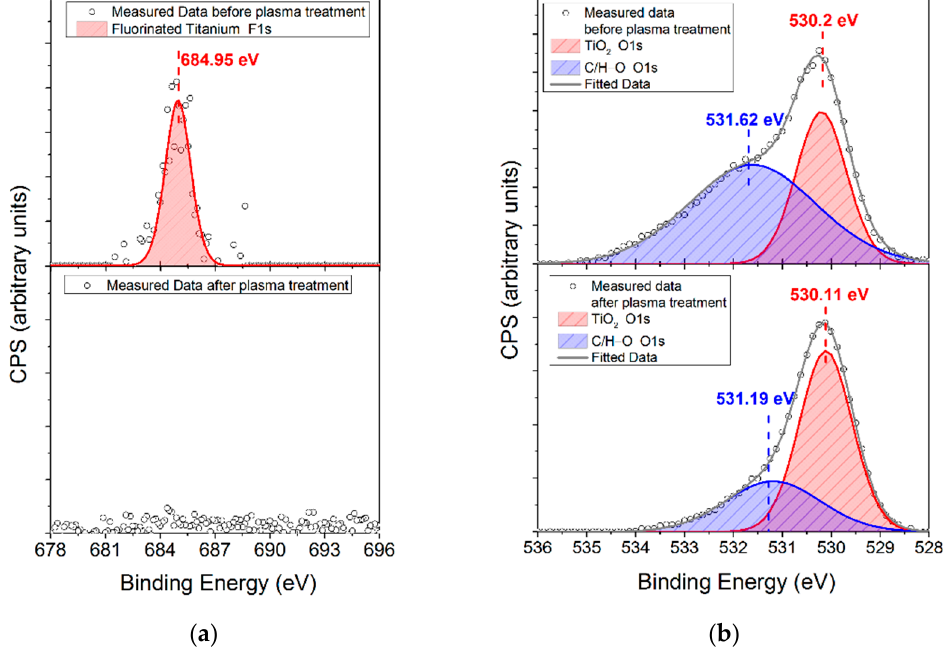
Figure 9. XPS spectra of ( a ) F1s and ( b ) O1s regions of cTi before and after oxygen plasma treatment.